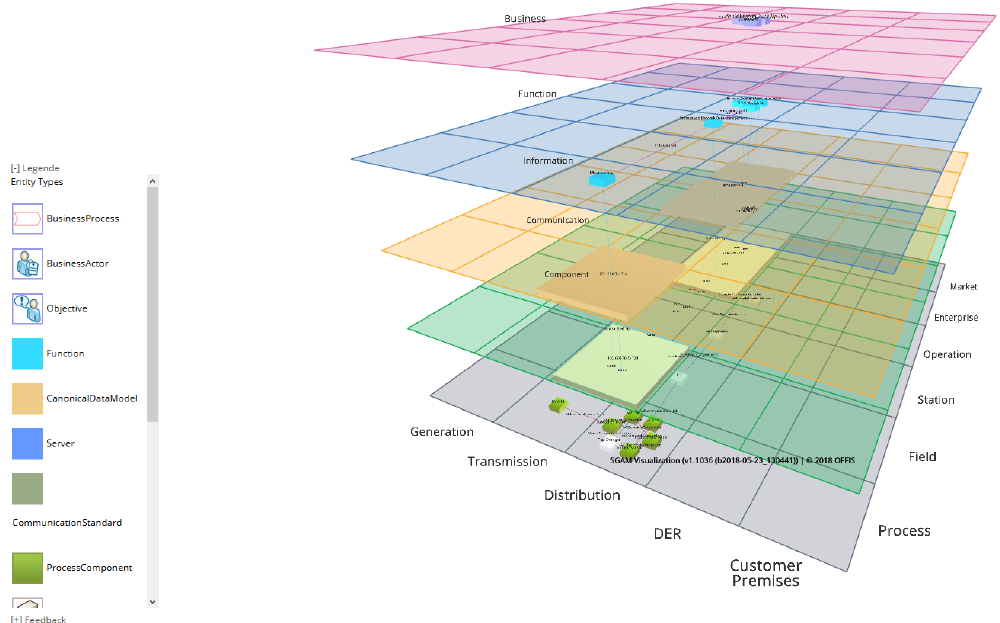
Figure 5. Visual import of a SGAM model for Substation Automation in the 3D SGAM